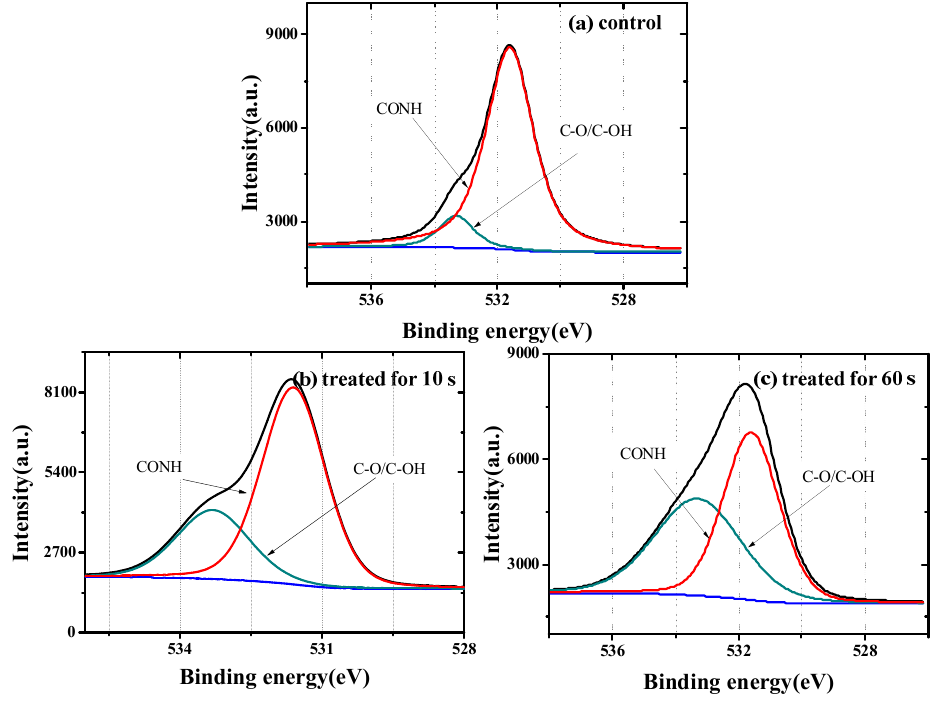
Figure 7. Synthesis curve of O1s-spectrums of the control and glow-like plasma processed samples: ( a ) Control; ( b ) Treated for 10 s; ( c ) Treated for 60 s.